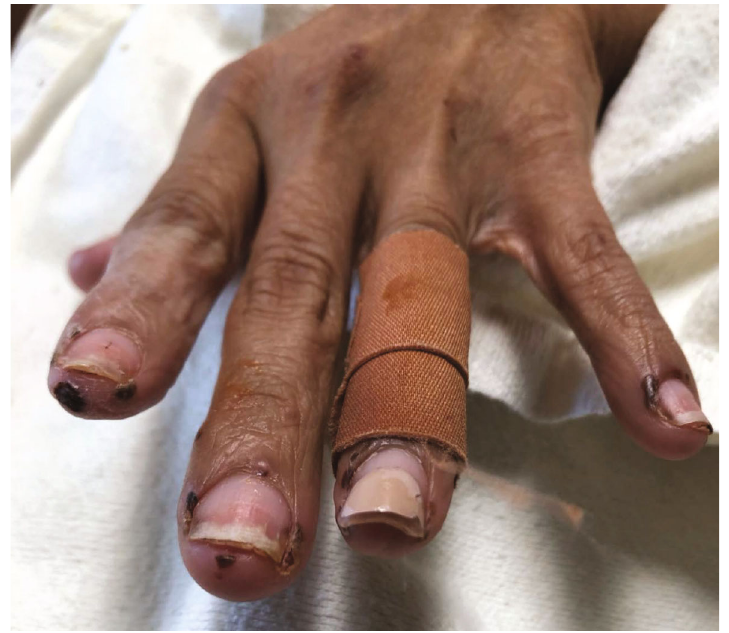
Figure 11: Small hemorrhagic vesicles on the hands of a bullous lupus